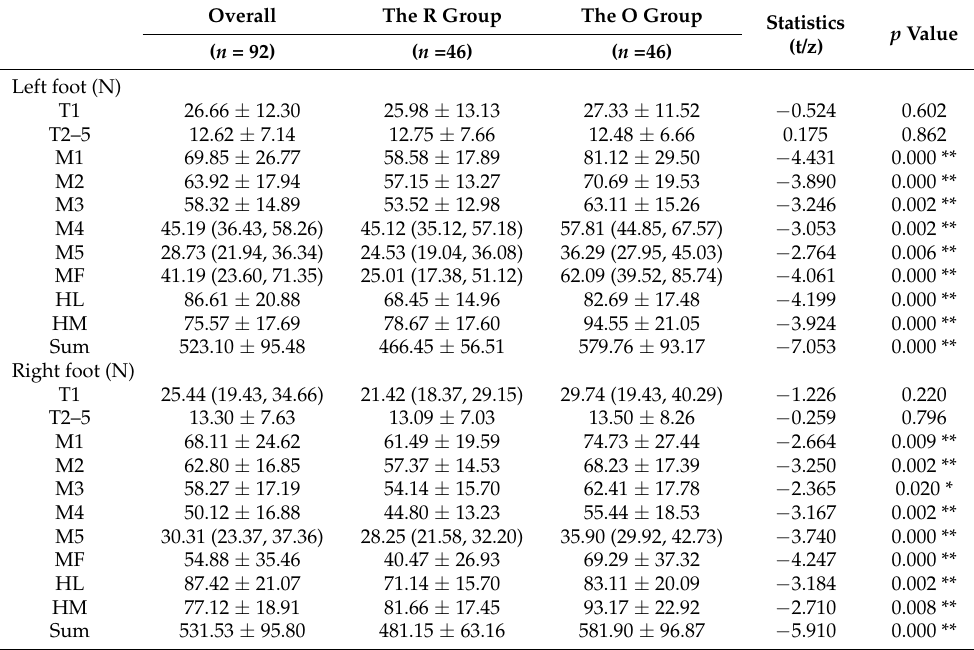
Table 5. The average force of the older women in the O and R groups. Overall The R Group The O Group